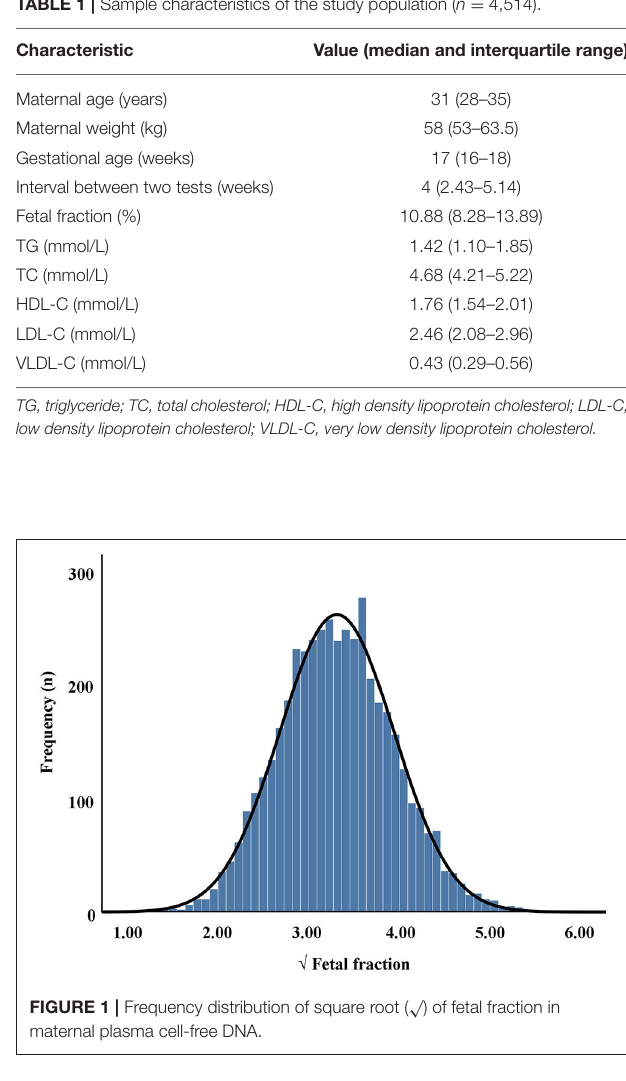
TABLE 1 | Sample characteristics of the study population ( n